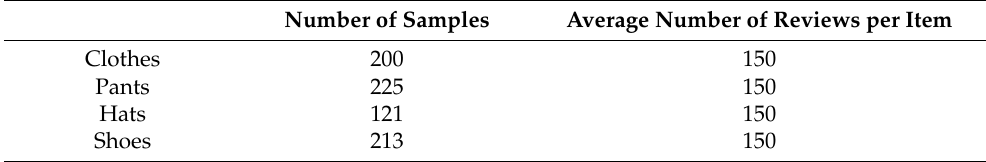
Table 1. Basic parameters of the clothes dataset.